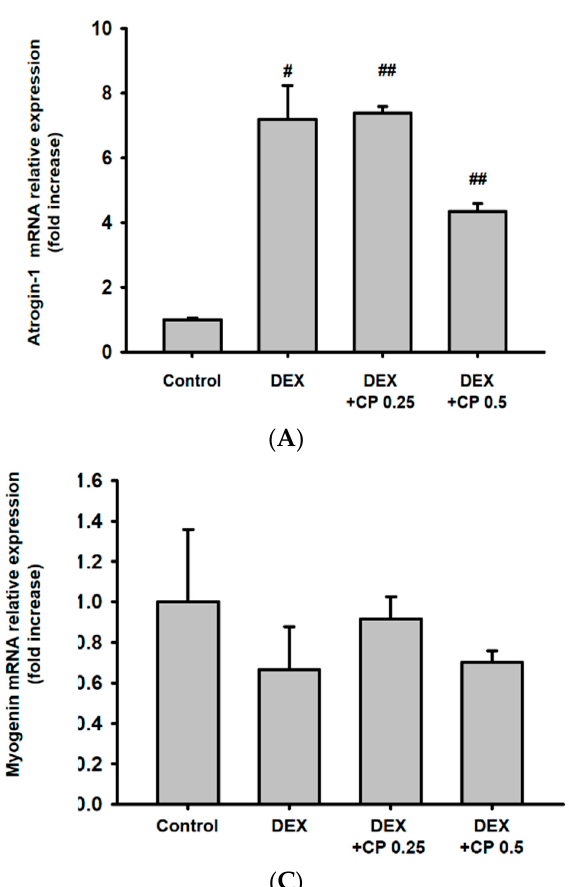
Figure 4. Effect of CP on muscle protein degradation pathway. ( A – C ) The mRNA expression of atrogin-1 ( A ), MuRF1 ( B ), and myogenin ( C ) in the muscles was assessed using real-time PCR. Data are presented as the means ± SD of values obtained from seven biological replicates. # p < 0.05, ## p < 0.01, DEX vs. control. # p < 0.05, ## p < 0.01, DEX + CP (0.25 and 0.5) vs. control. CP, collagen peptides; DEX, dexamethasone.